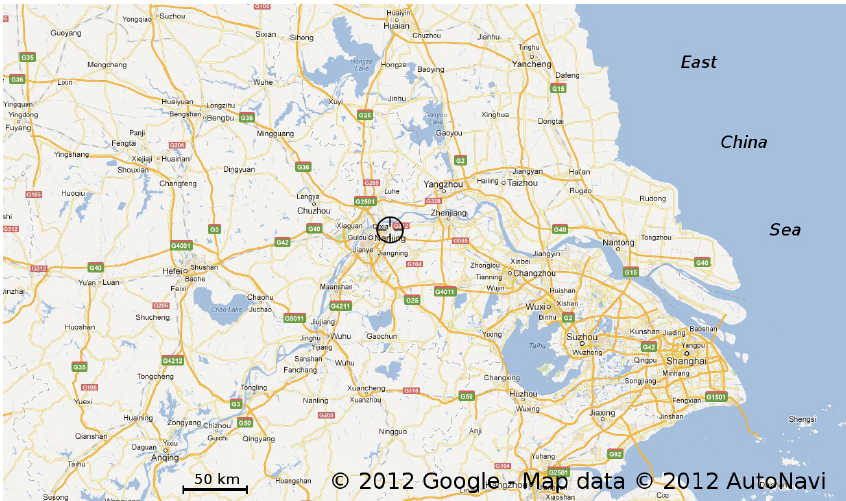
Fig. 1. Location of the SORPES-NJU measurement station within eastern China and the Yangtze River Delta (YRD).